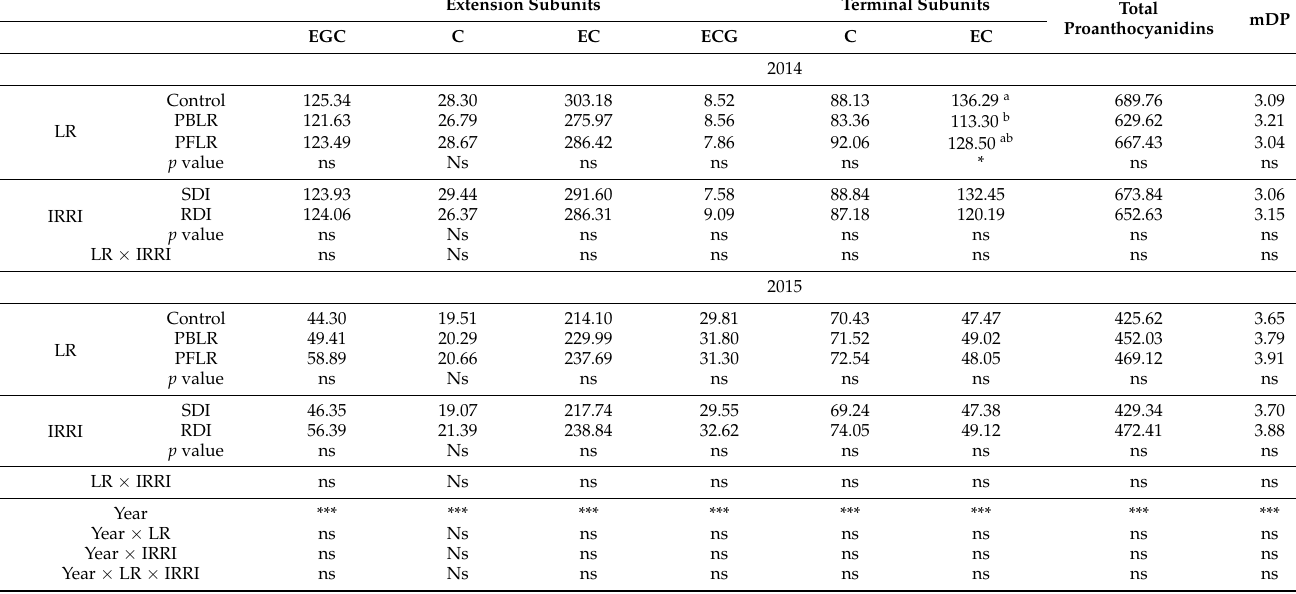
Table 5. Wine proanthocyanidin subunit concentration in a Merlot ( Vitis vinifera L.) vineyard in Denair, California in 2014 and 2015 a,b,c